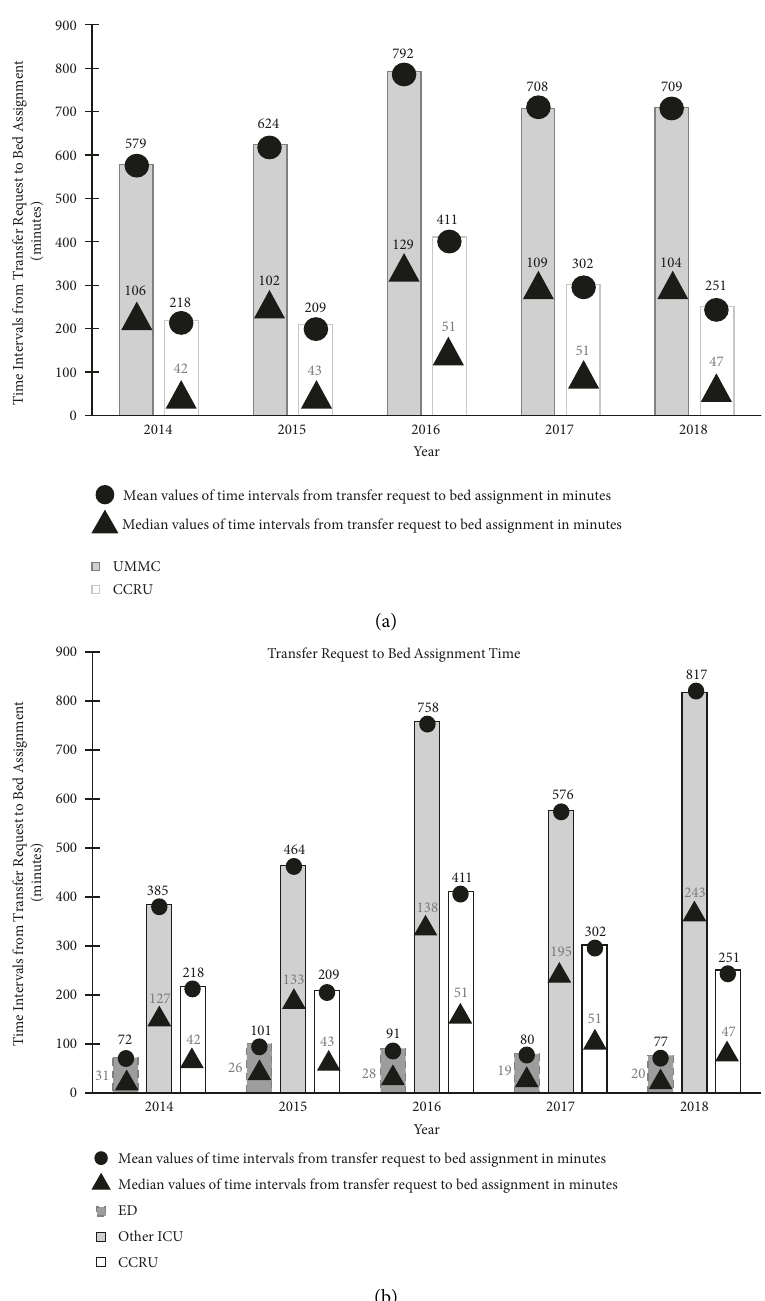
Figure 4: (a) Comparison of time intervals from transfer request to bed assignment for the critical care resuscitation unit (CCRU) and overall time intervals for transfer to our academic medical center (UMMC). Median of time intervals for UMMC and CCRU patients were analyzed using Mann–Whitney U tests with all P -values 0.001. Abbreviations: CCRU, critical care resuscitation unit; UMMC, University of Maryland Medical Center. (b). Comparison of time intervals from transfer request to each unit’s bed assignment for patients who were transferred from other hospitals to our academic medical center. Median time intervals for CCRU vs. other ICU and CCRU vs. ED transfer < were analyzed using Mann–Whitney U tests with all P -values 0.001. Abbreviations: CCRU, critical care resuscitation unit; ED, <